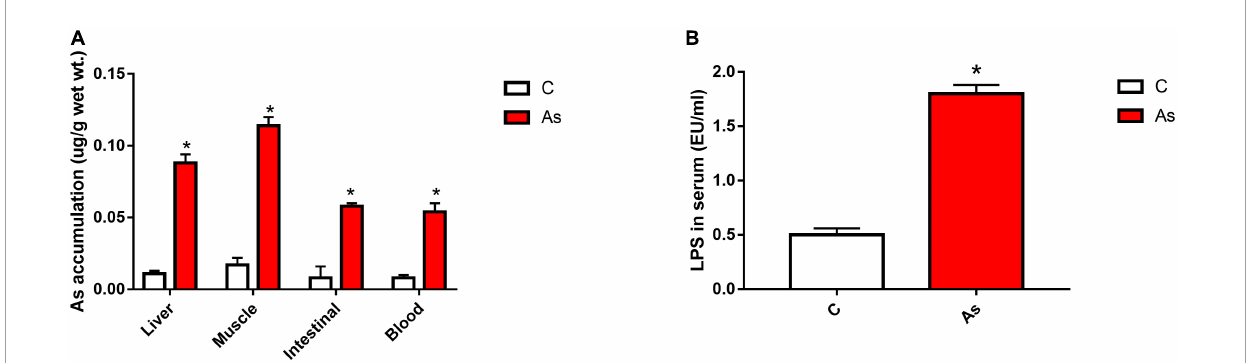
FIGURE2 Effect of arsenic (As) exposure on As accumulation in tissues (A) and lipopolysaccharide (LPS) levels in serum (B) . The data are presented as the means ± standard deviations of three parallel measurements. * P < 0.05 indicates a significant difference between the two groups.